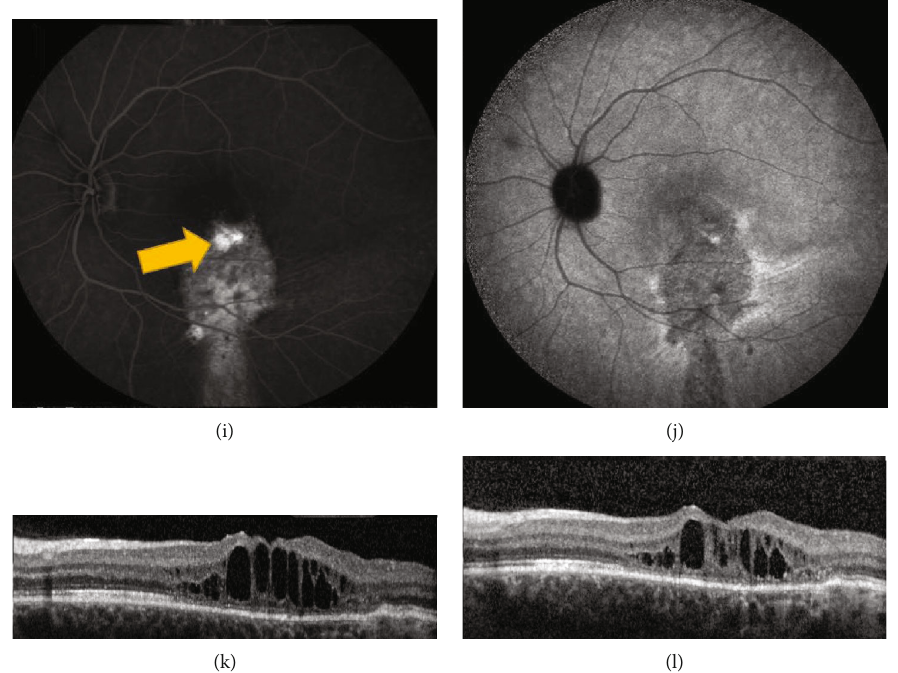
Figure 8: Chronic central serous chorioretinopathy treated with thermal laser photocoagulation. A 21-year-old female presented with visual distortion for over one year. Visual acuity in the left eye was 20/150 at presentation. (a – f) Images at baseline. (a) Early-phase fl uorescein angiography (FA) showed a broad area of hyper fl uorescence. (b) Early-phase indocyanine green angiography (ICGA) showed areas of hypo fl uorescence corresponding to the hyper fl uorescence on FA. (c) Late-phase FA showed extrafoveal focal leakage, noted by the yellow arrow. (d) Late-phase ICGA showed hyper fl uorescence corresponding to the focal leak on FA. Thermal laser was applied to the area corresponding to the leakage on FA and ICGA. Visual acuity improved to 20/100. (e) Optical coherence tomography (OCT) prior to thermal laser showed subretinal fl uid and “ shaggy ” photoreceptors. (f) Post thermal laser, there was improvement in subretinal fl uid. The patient was lost to follow-up but returned three years later with worsening symptoms. Visual acuity was 20/800. (g) Early-phase FA showed broad hyper fl uorescence. (h) Early-phase ICGA showed hypo fl uorescence. (i) Late-phase FA showed two small areas of extrafoveal focal leakage, noted by the yellow arrow. (j) Late-phase ICGA showed one area of focal hyper fl uorescence corresponding to the leakage on FA. (k) OCT prior to repeat thermal laser treatment showed loss of outer retinal layers with recurrent intraretinal fl uid. (l) OCT following the second argon photocoagulation (yellow arrow in (i)) showed improvement in fl uid as well as macular thickness. Visual acuity returned to 20/150 after